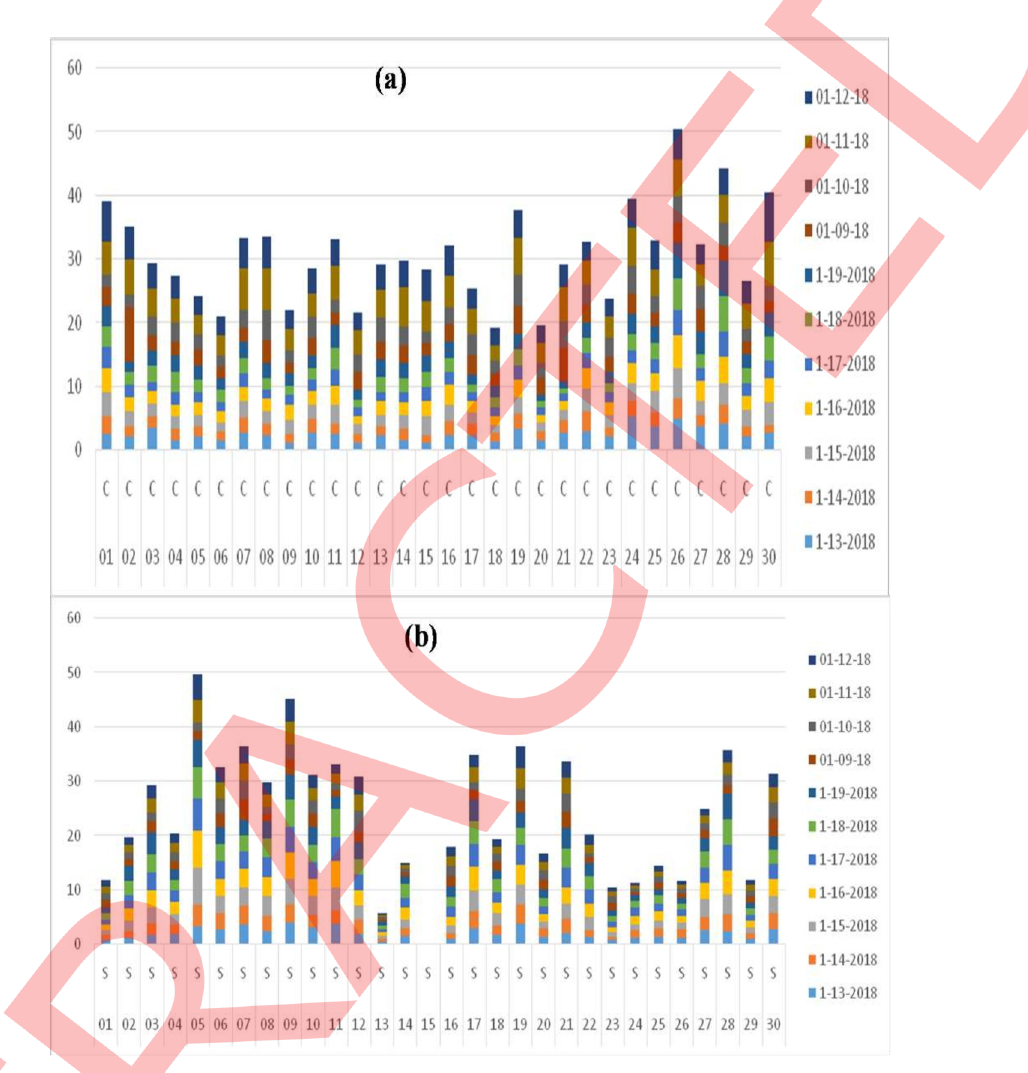
Amongst the other surrogates predicted from the study besides the above mentioned include area, boundary point count, boundary point roundedness, calliper length and centre of mass to boundary distribution, compactness, convex hull circumference, mean colour red and object sum Area. These surrogates differentiated the inbred lines between control and stress conditions except KDM-340A in area, CML-286, CML-470 in boundary point count, boundary point roundedness, calliper length, centre of mass to boundary distribution and compactness, and V-351 for convex hull circumference, mean colour red, object sum area and minimum enclosing circle diameter. The relationship between different surrogates and bio- mass in control and stressed pots shows stronger association in all surrogates in control as compared to stressed plants except area, which has association significant in both situations (Figs 6 & 7). Two new holistic phenes were observed in the study, i.e., bi-angular convex-hull area ratio and plant aspect ratio. Bi-angular convex-hull area ratio is defined as the ratio of the convex-hull area of the plant when observed from the side at a particular angle and the